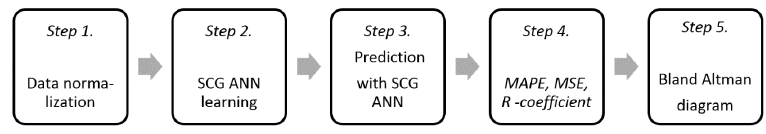
Figure 10. Block scheme summarizing the experiment steps.